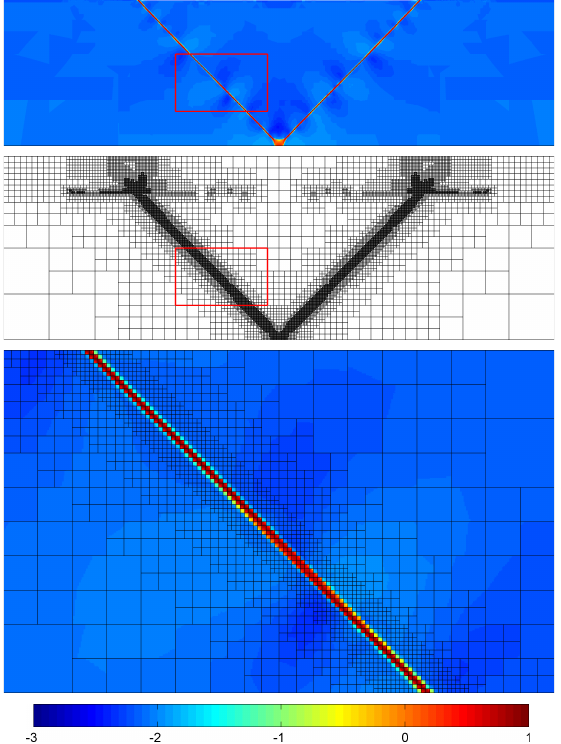
Figure 20. Extension model with φ = 0 ◦ after 0.53% strain; top : log ( ˙ ε II ) plot; middle : numerical grid; bottom : zoom as marked by red rectangles.